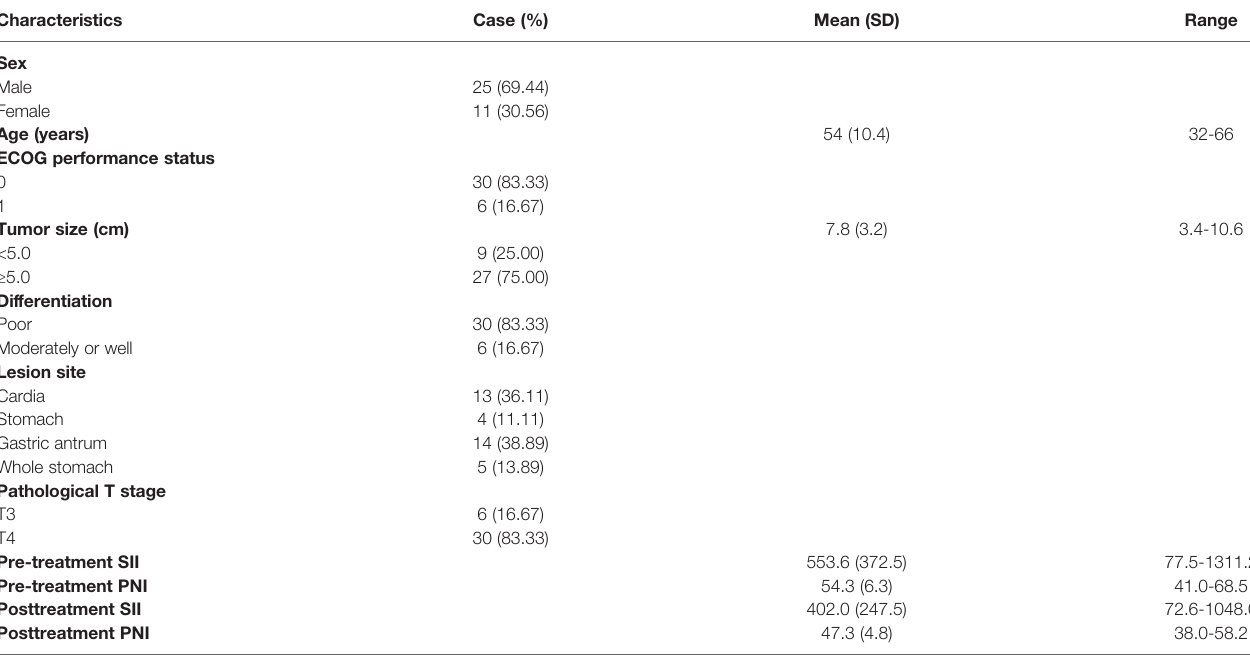
TABLE 1 | Patient demographic information and tumor characteristics.